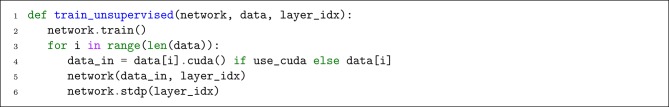
Helper function for unsupervised learning.